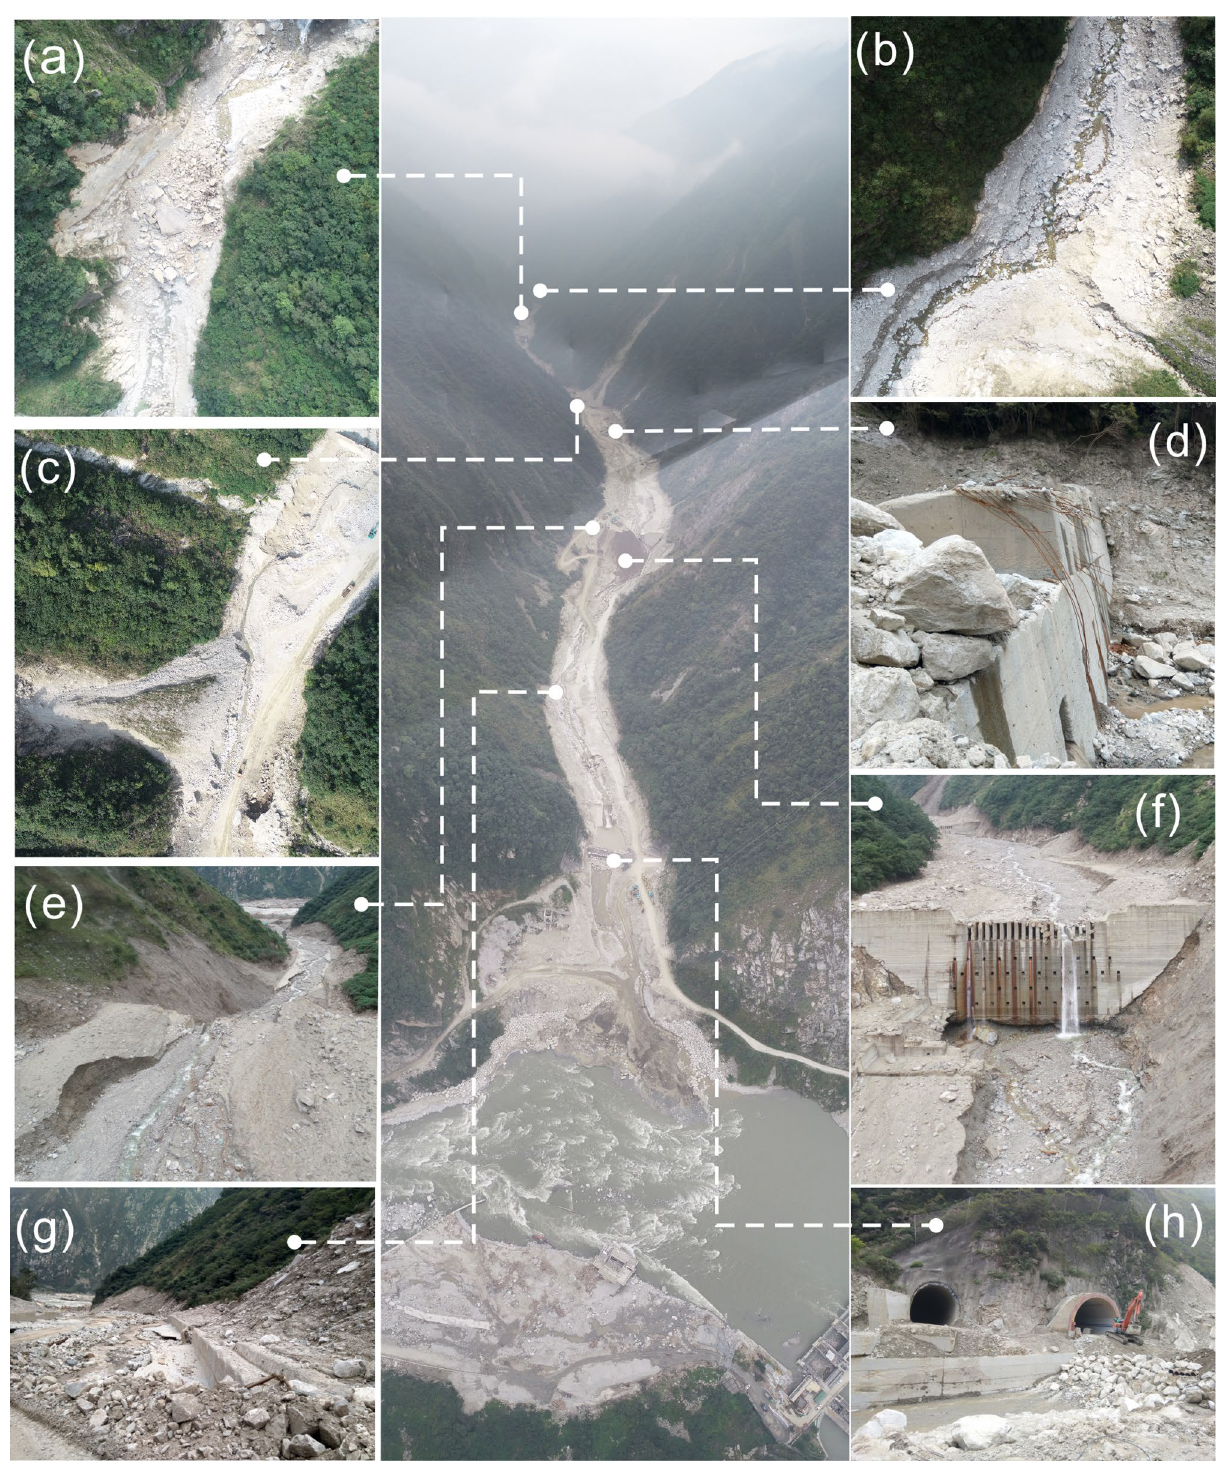
Figure 14. Characteristics maps of Chediguan debris flow broken in 20th August. ( a ) the collapse in front of no. 4 dam due to erosion by water flow; ( b ) the debris fan of no.8 tributary was eroded; ( c ) the old deposition fan and slope behind no 2 dam was eroded; ( d ) the no. 2 dam was destroyed; ( e ) channel erosion characteristics below no 1 dam; ( f ) the channel in front of no. 1 dam was severely down-eroded; ( g ) the drain groove at the gully mouth was completely destroyed; ( h ) two Bridges at the gully mouth were washed away. Maps constructed using Coreldraw × 7 (https:// www. corel. com/